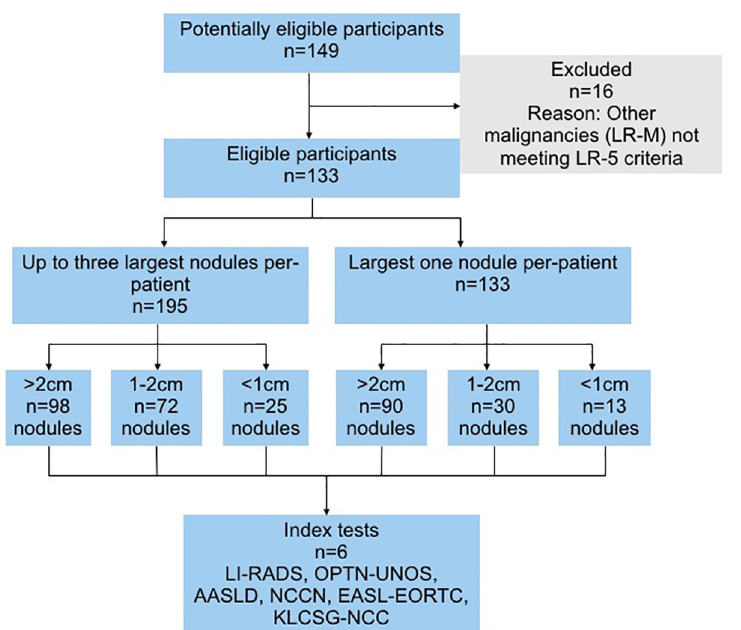
Fig 1. The diagram of the flow of the participants through the study.